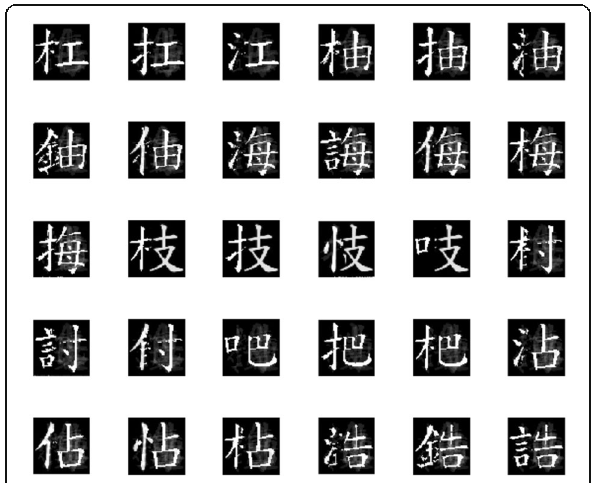
Fig. 4 Reconstruction results based on the two matrices, W and H , for the matrix V , formed by the Chinese characters displayed in Fig. 2